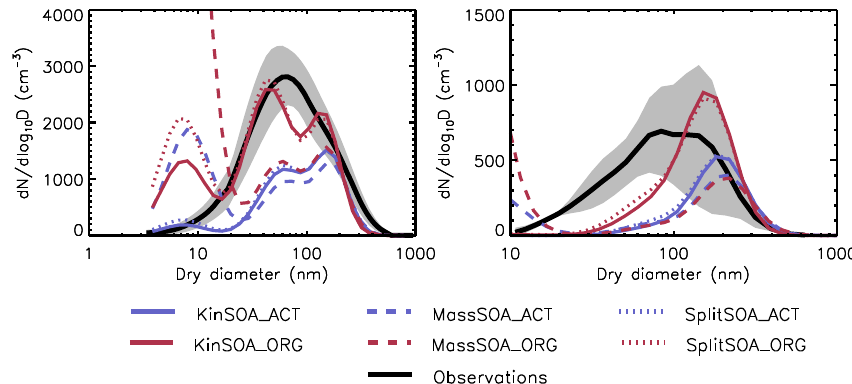
Figure 1. Simulated and observed mean aerosol number size distributions at two forested sites. (Left) Hyytiälä, Finland, during June– July–August (multi-annual; 1996–2006). (Right) Manaus, Brazil, during the wet season (multi-annual; January–June, 2008–2009). The grey shaded regions indicate ± 1 standard deviation from the seasonal mean, calculated from the observed monthly mean size distributions (over all years). In each figure, simulations show the sensitivity to the nucleation mechanism (activation (blue) and organically mediated (red)) and condensation assumption (kinetic (solid), mass-based (dashed) and 50% split kinetic and mass-based approaches (dotted)). Table 2. Global annual mean change to CDNC, calculated using a globally uniform updraught velocity of 0.2ms − 1 , in the model level corresponding to low-level cloud base (mean pressure of approx. 900hPa), first AIE and DRE due to biogenic SOA in GLOMAP using the kinetic and mass-based approaches. Nucleation Background Distribution of (cid:49) CDNC AIE DRE mechanism (without biogenic SOA) secondary organic (Wm − 2 ) (Wm − 2 ) global annual material mean CDNC (cm − 3 ) ACT 185.2 KinSOA + 6 . 3 ( + 3.4%) − 0.07 − 0.10 MassSOA + 2.6 ( + 1.4%) + 0.01 − 0.11 SplitSOA + 5.9 ( + 3.2%) − 0.05 − 0.11 ORG 165.2 KinSOA + 34.8 ( + 21.1%) − 0.66 − 0.09 MassSOA + 27.8 ( + 16.8%) − 0.50 − 0.08 SplitSOA + 33.77 ( + 20.4%) − 0.63 − 0.09 ORG_x10 165.2 KinSOA + 41.5 ( + 25.1%) − 0.78 − 0.08 MassSOA + 33.0 ( + 20.0%) − 0.59 − 0.08 SplitSOA + 40.3 ( + 24.4%) − 0.75 −